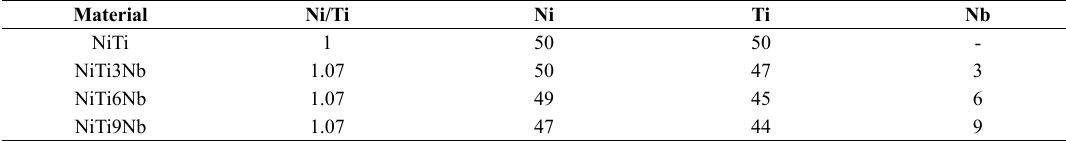
Table 1. Nominal composition of the alloys (% atomic).